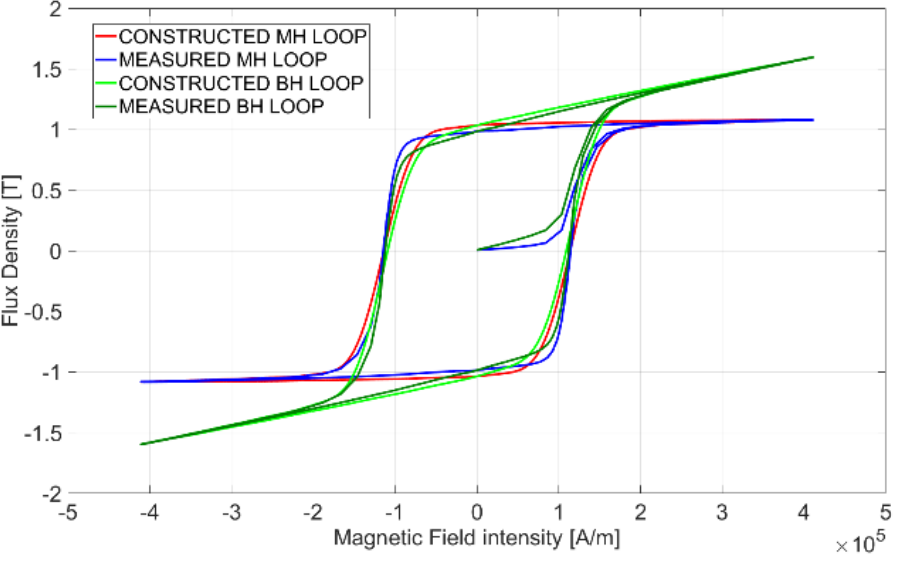
Figure 5. Comparison between constructed and measured hysteresis loop.